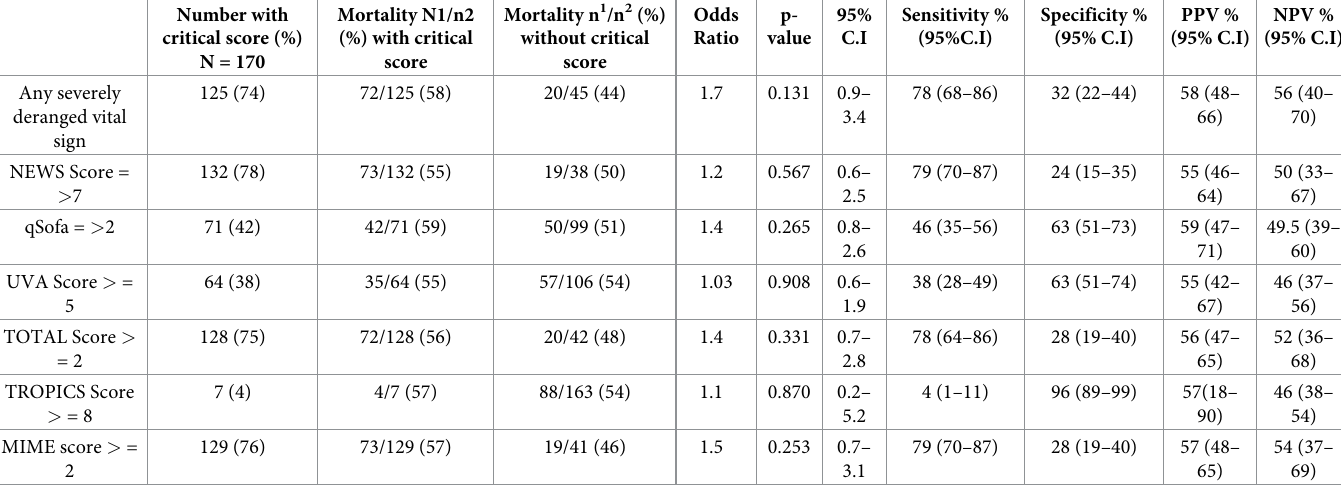
Table 4. Predictive values of severity score models for medical patients over 16 years. Number with critical score